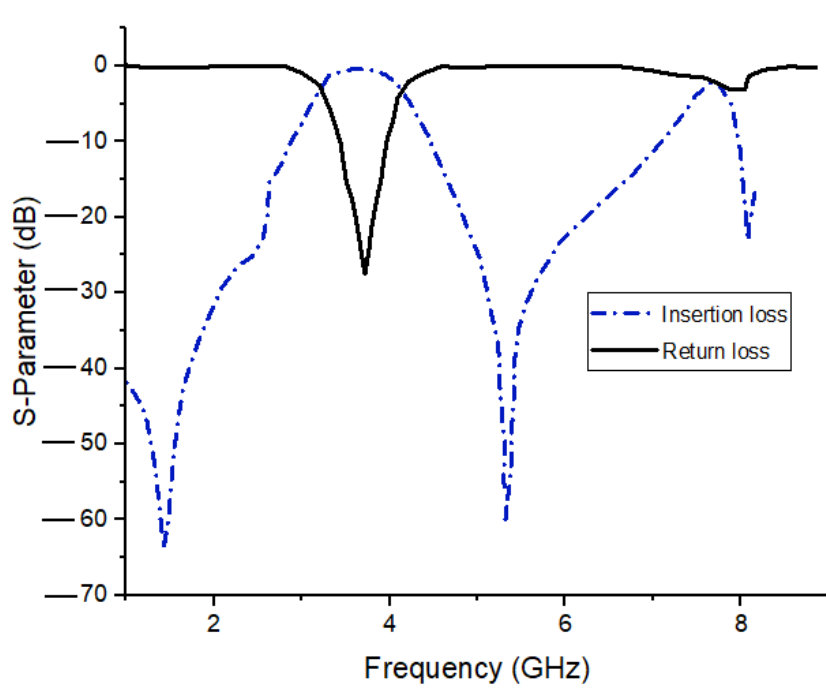
Figure 12. Insertion loss of cavity resonator.